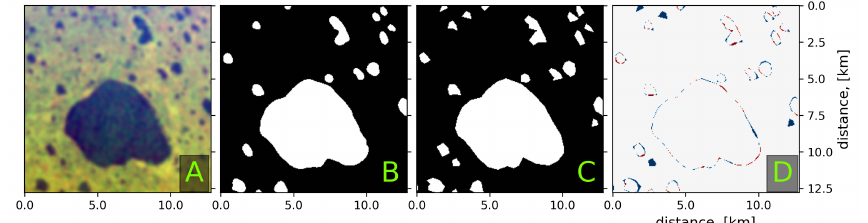
Figure 5. Results of tundra lakes recognition from Sentinel-1 data taken over the Yamal Peninsula (69.4366 ◦ E, 68.5102 ◦ N) from 23 August 2016 at 12:49:16 by our algorithm framework: ( A ) input pseudo-RGB image where R = SAR backscattering at HV-polarization, B = SAR backscattering at HH-polarization and G = incidence angle; ( B ) predicted tundra lakes (white) ( C ) ground truth image with manually mapped lakes; ( D ) the difference between ground truth and predicted data, where red indicates pixels corresponding to lakes in the framework output but not in the ground truth, blue corresponds to pixels recognized as lakes in the ground truth but not in the framework output and white stands for agreement between the